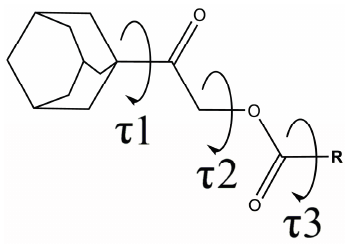
Figure 1. General chemical scheme for all compounds, showing τ 1, τ 2 and τ 3 as torsion